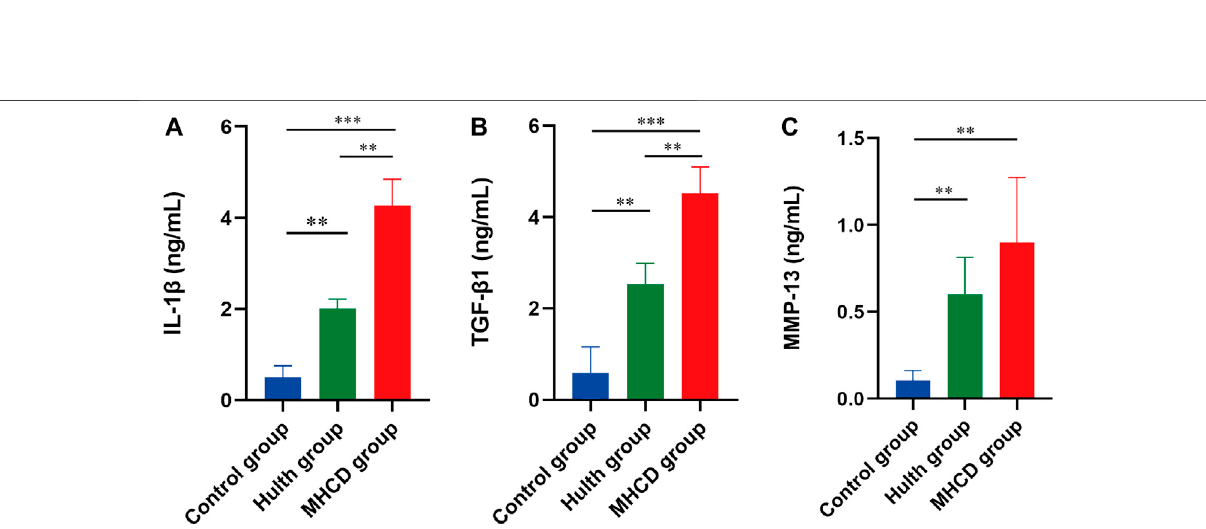
FIGURE 8 | Staining of glycosaminoglycans in articular cartilage 180 days after surgery. Representative images of (A) Safranin O and (B) toluidine blue staining.